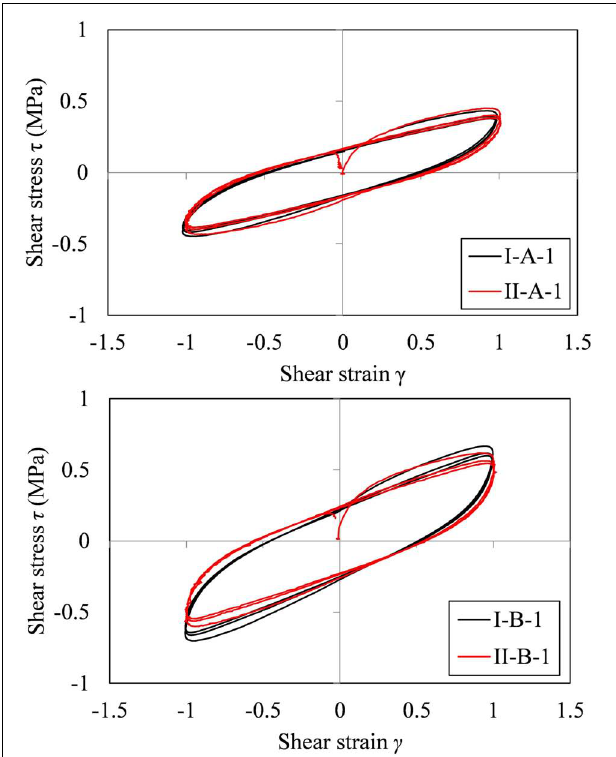
FIGURE 3 | Shear stress-strain relationship of scale-I and-II of rubber-A and -B for all three cycles.